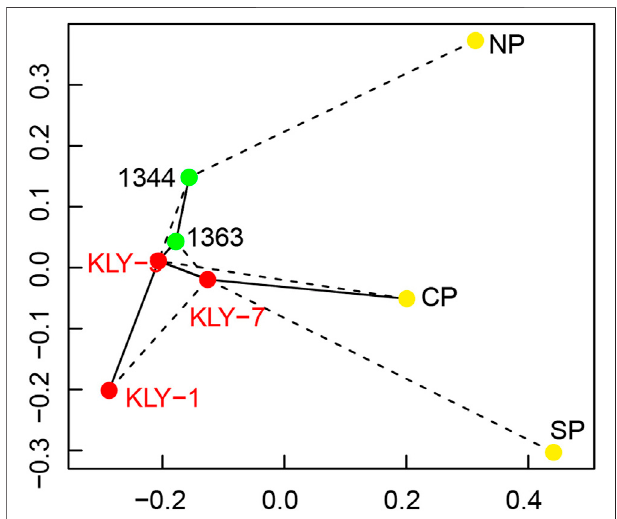
FIGURE 7 | Non-metric multi-dimensional scaling (MDS) plot between the sample U/Pb ages and potential source regions. Data from the North Pamir are from Blayney et al. (2016), Carrapa et al. (2014) and Rittner et al. (2016). Data from the Central Pamir are from Luckens et al. (2012). Data from the South Pamir are from Blayney et al. (2016). Samples 1,344 (Tinzip River) and 1,363 (Karakax River) are from Blayney et al. (2016). The solid and dashed lines show the fi rst and second closest neighboring samples,